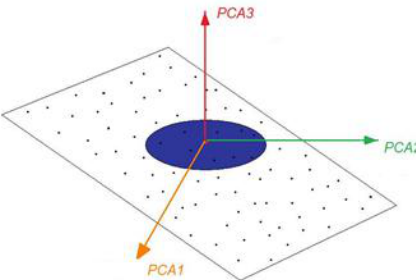
Figure 3. Normal Vector calculation using